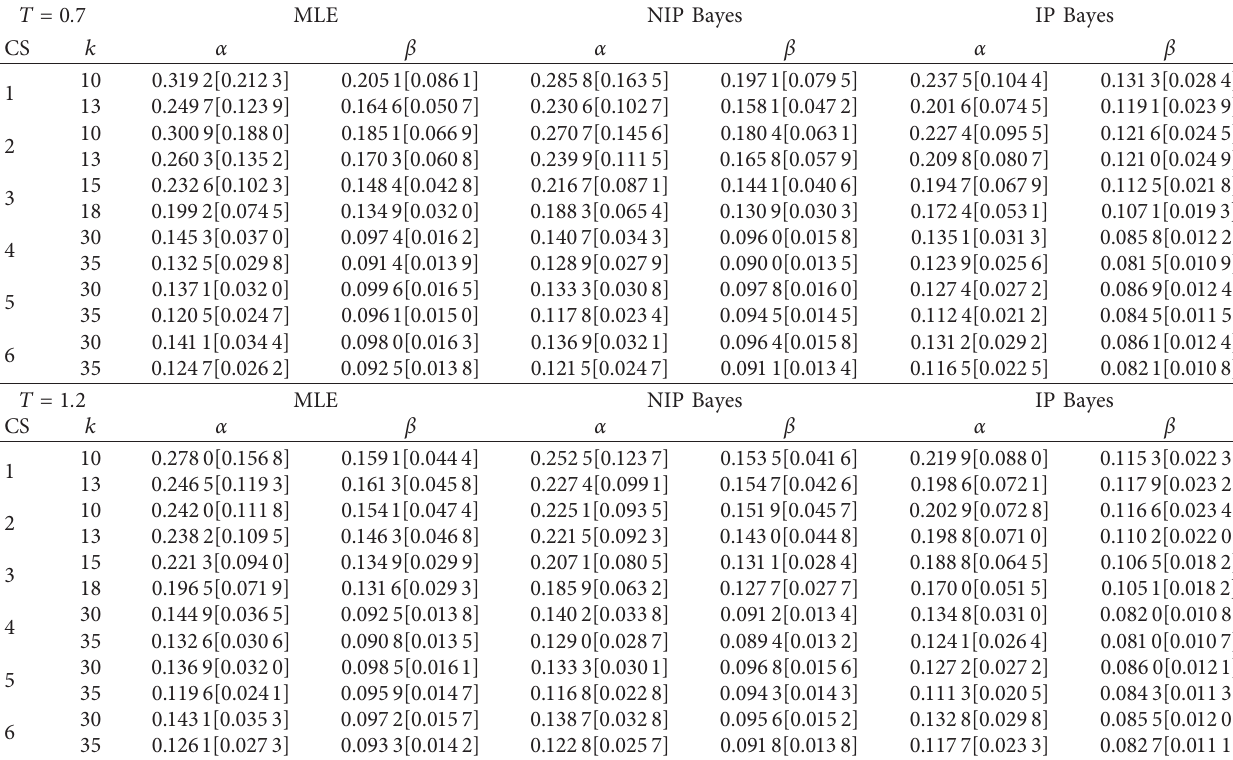
Table 1: ABs and MSEs (within brackets) of the MLEs and Bayes estimates under generalized progressively hybrid censored data with ( α , β ) � ( 1 , 0 . 6 ) .